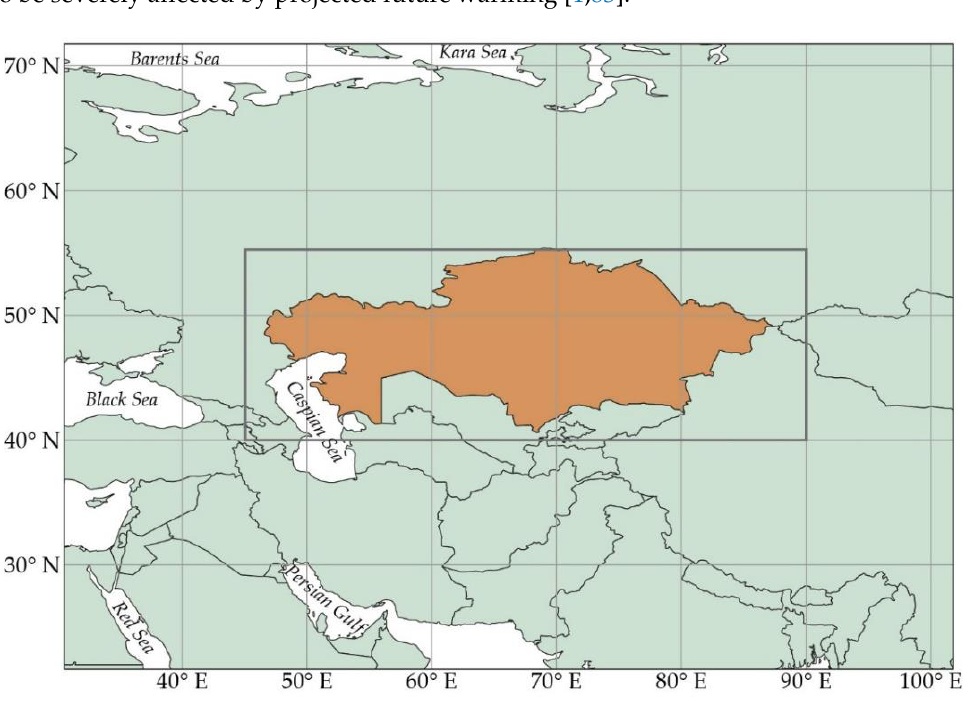
Figure 1. Geographical location of the study region. The gray rectangle shows the boundaries of the area selected for analysis of the spatial variability of dryness conditions.